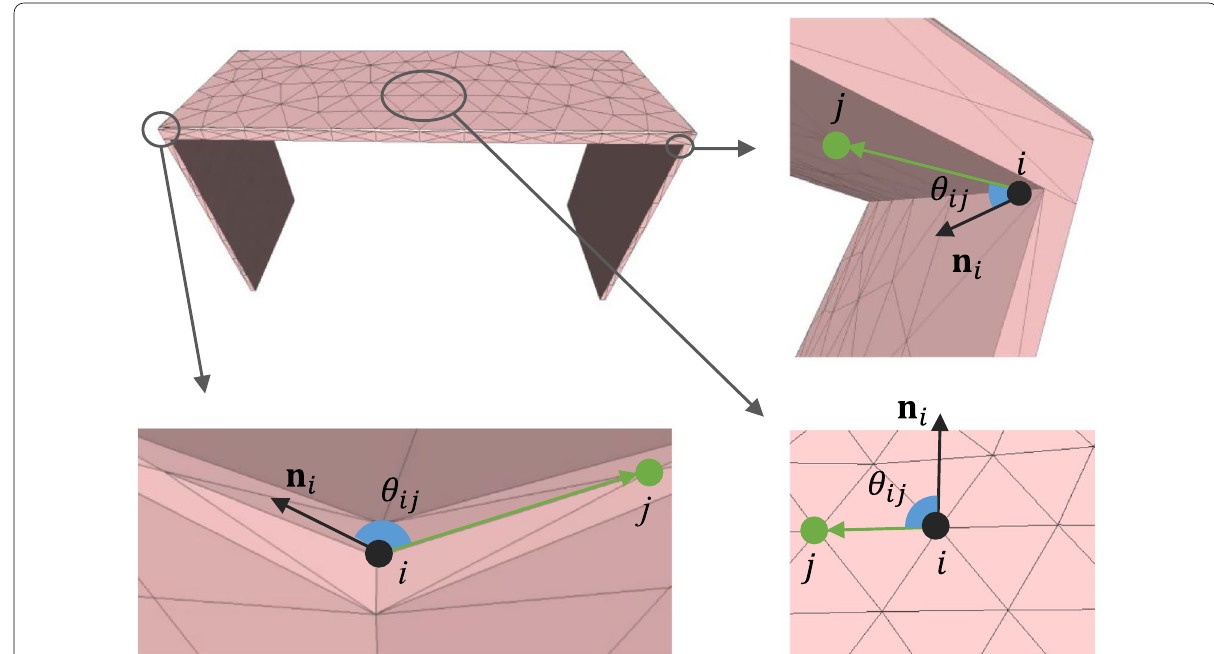
Fig. 5 This is a 3D model of a desk. In the bottom right figure, the desktop is flat and the normal vector n i is perpendicular to the local area. For each j ∈ N i , θ ij = 90 ◦ . The bottom left figure and the top right figure are the convexity and concavity of the the desk respectively, with θ ij > 90 ◦ and θ ij < 90